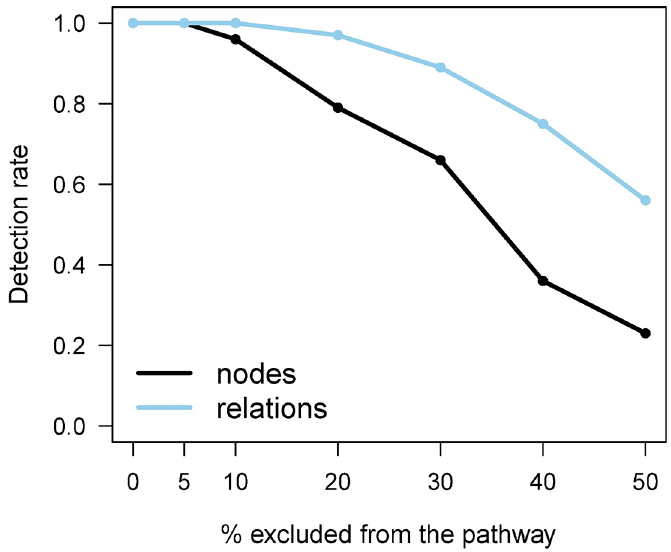
Fig 4. Effect of structural uncertainty. Rate of detection (y-axis) of the MAPK signaling pathway among the top 25 pathways when removing different percentages (x-axis) of nodes or relations from it. Reduction was done separately for nodes (black line) and relations (blue line). 100 random reductions for each proportion were used to calculate the detection rates in dataset T1D_1.